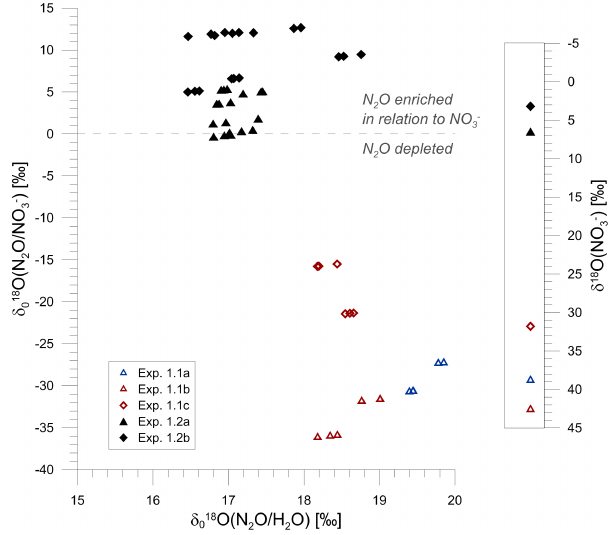
Figure 3. Relation between relative isotope ratio differences be- tween produced N 2 O and soil water ( δ 18 tween produced N 2 O and soil nitrate ( δ 18 right δ 18 O values of the initial soil nitrate for different treat- ments. δ 18 O values of the initial soil water ranged between − 13.5 and − 1.6 ‰ (see Table 1) and its variation had no impact on δ 18 O(N 2 O / H 2 O). Open symbols: treatments with synthetic nitrate 0 as fertilizer, filled symbols: treatments with natural Chile saltpeter as fertilizer. Data from Exp